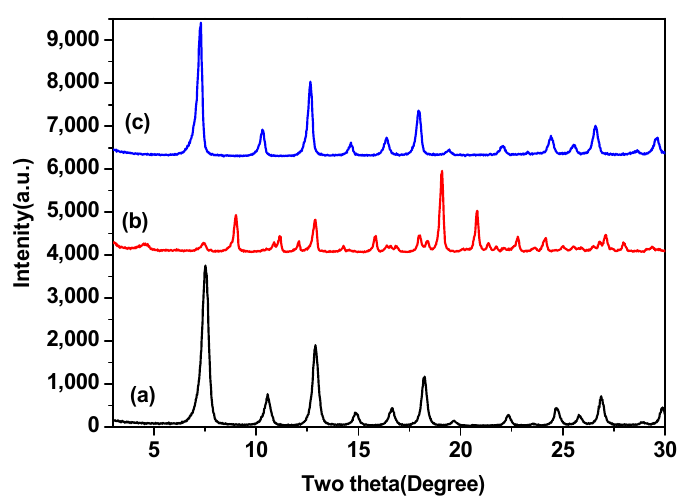
Figure 6. XRD patterns of fresh ZIF-8 (a), recovered ZIF-8from the reaction betweenbenzaldehyde and malononitrile in water at 40 °C (b) and recovered ZIF-8 from the reaction between 2-nitrobenzladehyde and malononitrile in water at 40 °C (c). The recycle experiment was carried out using the Knoevenagel condensation between 2-nitrobenzaldehyde and malononitrileat 40 °C in a biphasic system as a test reaction. Although some solid was lost during the centrifugation, as shown in Figure 7, the yields in the consecutive cycleswerealmost the same asthoseof the first cycle. XRD patterns of ZIF-8 before and afterreaction (Figure 8) revealedbetter integrity in the framework structure, but the TEM image (Figure 9c) demonstrated the presence of newly-formed mesoporous cages in the recovered solid. The retainedor improved specific activity canprobably be attributedto the more exposed active site and better mass transfer in the hierarchical ZIF-8. A hot filtration experiment was further performed to confirm theheterogeneous nature of the catalytic reaction (Figure 10). The solid catalyst was removed from hot solution by filtration 10 min after initiating the catalytic test run. The reaction of the filtrate was then monitored for another 50 min. No significant further conversions were observed, indicating that most of the conversions were theresult ofthe heterogeneous catalysis.